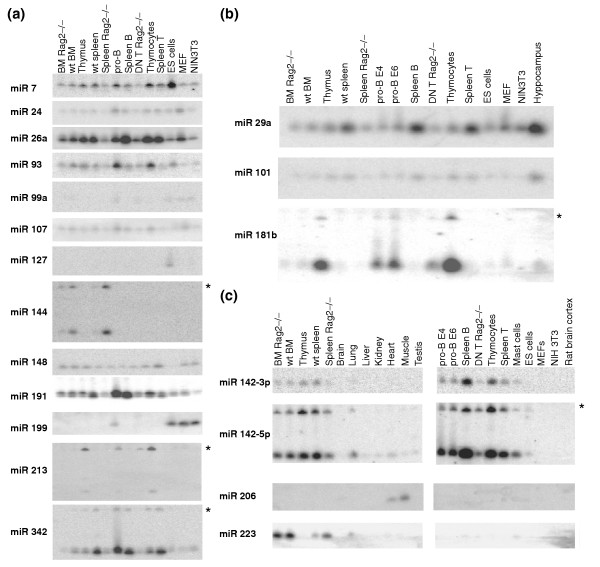
Additional Northern blots showing miRNA expression in various tissues and cell types. Shown are Northern blot data for the indicated miRNAs in different unstimulated cell types. Asterisks indicate bands of the size of pre-miRNA (60-70 nucleotides), which were detected in Northern blot for only a subset of the miRNAs analyzed. There was a good correlation overall between Northern blot data and expression data from the arrays (see heat map in Figure 5 and Table 2), with some exceptions, as discussed in the text. BMMC, bone marrow-derived mast cells; DN T, double-negative thymocyte.